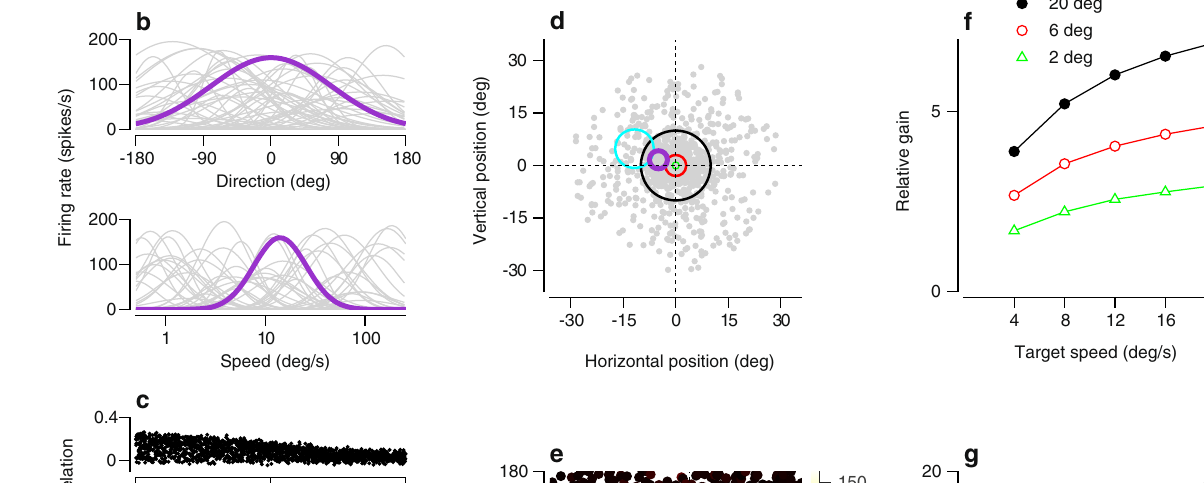
averaging, which predicts negative correlations for target speeds higher than the preferred speed of a given neuron 24 . Overall, the presence of gain noise has the expected effect of adding downstream noise. It both increases the variance of model output and partially decorrelates the responses of MT neurons from model output 15 .